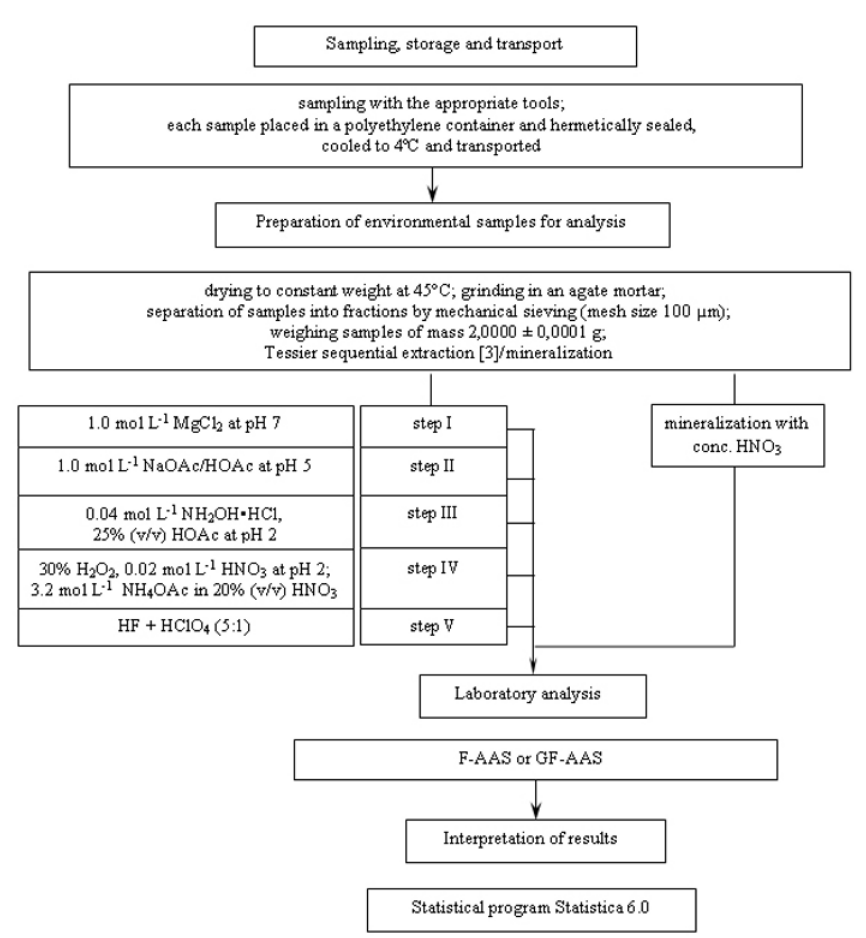
Figure 2. Scheme of the procedure for bottom sediment